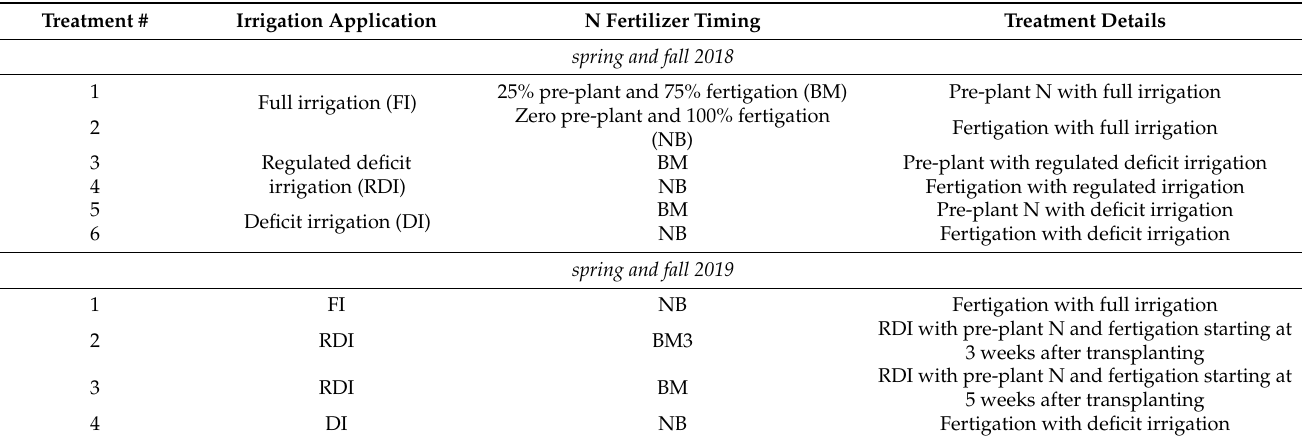
Table 2. Treatment specifications during the 2018 and 2019 growing